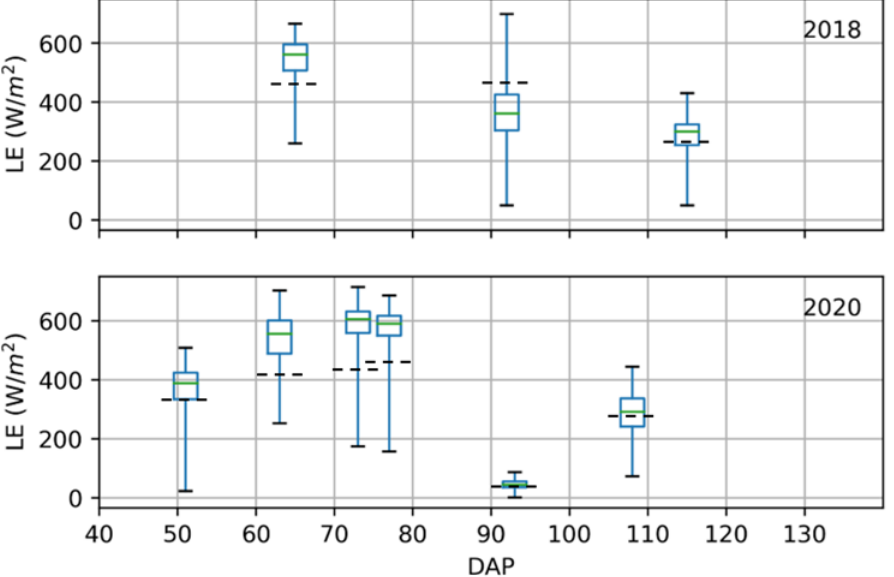
Figure 6. Box plots of latent heat flux distribution estimated from UAS imagery within the sample area of target plots in Field 54 north, where the black dashed lines indicate the latent heat flux values calculated from the Penman-Monteith equation for the time of observation and top whisker indicates the highest LE values, the top of the box indicates the 25th percentile LE, the middle line indicates the median LE, the bottom of the box indicates that 75th percentile LE, and the lower whisker indicates the lowest values of LE. The x-axis is labeled based on the days after planting (DAP), which is specific to the year and field being evaluated.